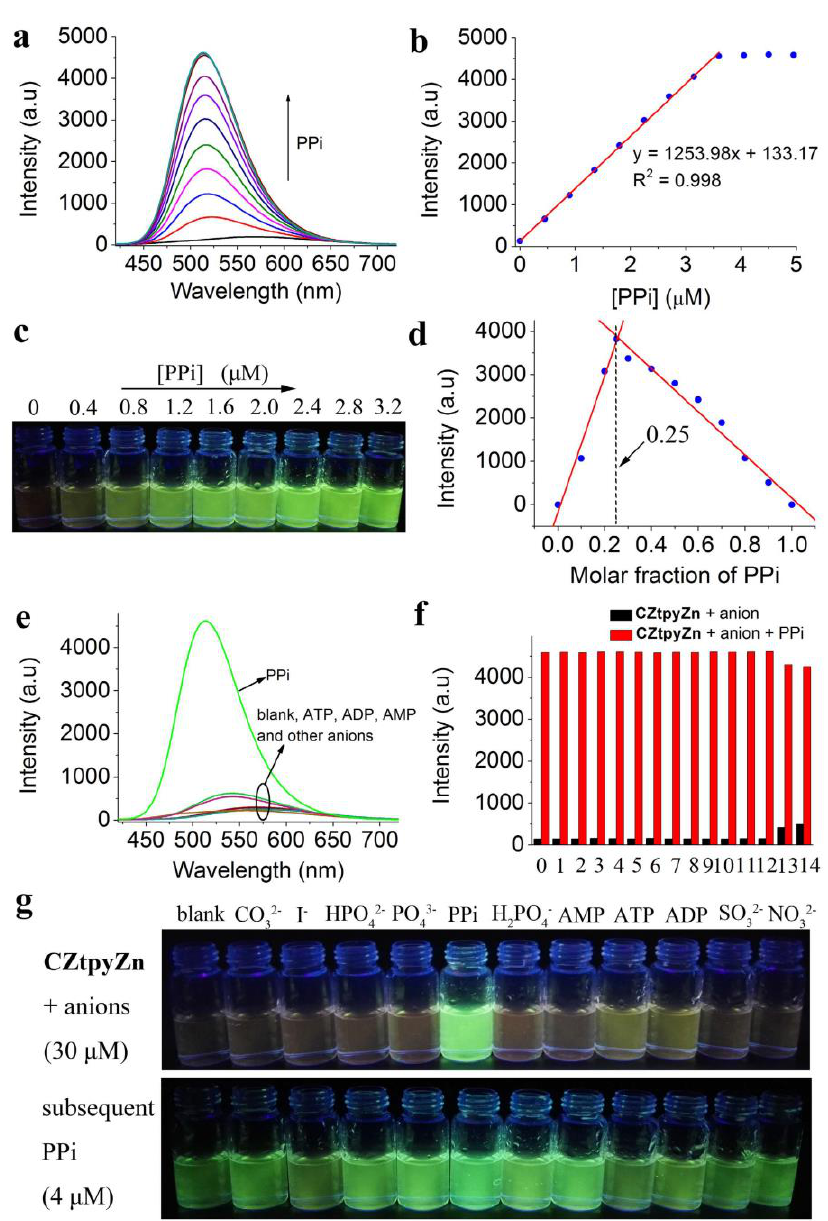
Figure 9. ( a ) Spectrofluorometric titration studies of D7 with PPi, with the plot of fluorescence intensities at 515 nm vs. PPi concentration shown in ( b ). ( c ) Photos showing the emission changes of D7 in the presence of increasing PPi concentration. ( d ) Job plot of binding study between PPi and D7 . ( e ) Fluorescence spectra of D7 in the separate presence of PPi and different anions. ( f ) Fluorescence responses of D7 at 515 nm to various anions with and without PPi, with the corresponding photos shown in ( g ). Reproduced with permission from [106]. Copyright 2016, Springer Nature Publishing AG.